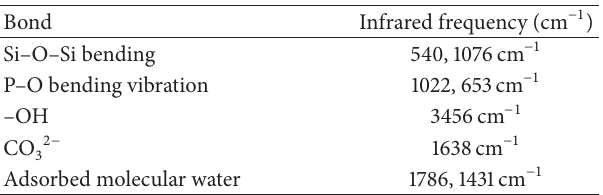
Table 2: Peaks of infrared spectra assigned to synthesized bioglass powder.